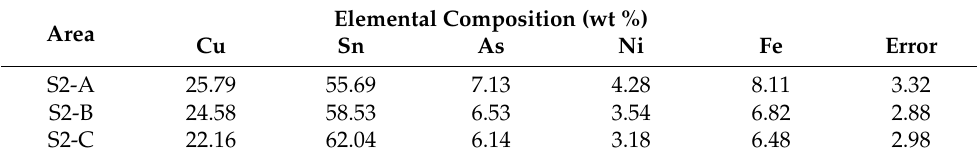
Table 3. Elemental chemical composition of the areas on the plateau right of the middle incision. Area